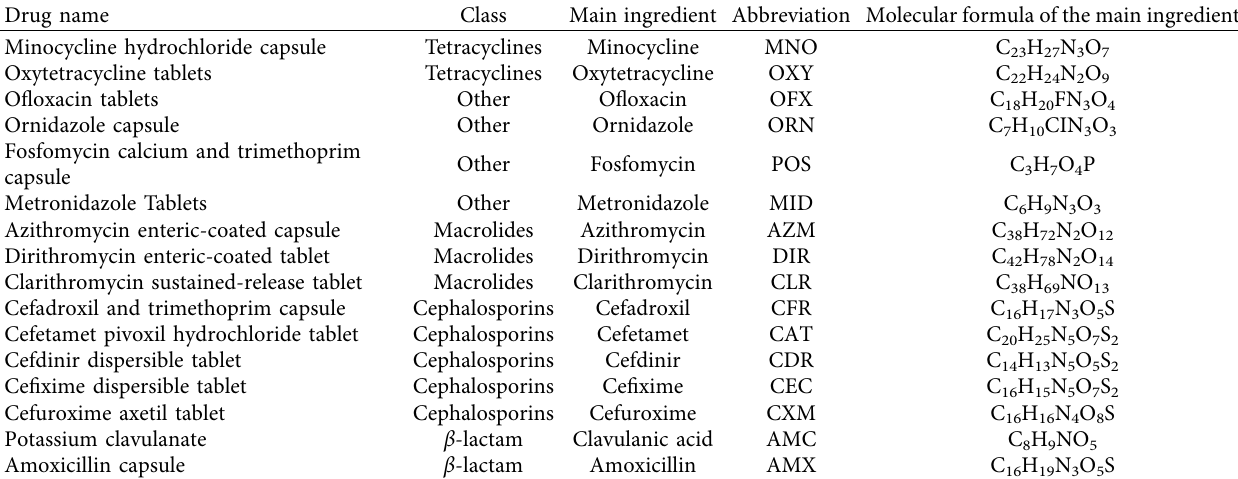
Table 1: Information for the sixteen types of antibiotics. Main ingredient Abbreviation Molecular formula of the main